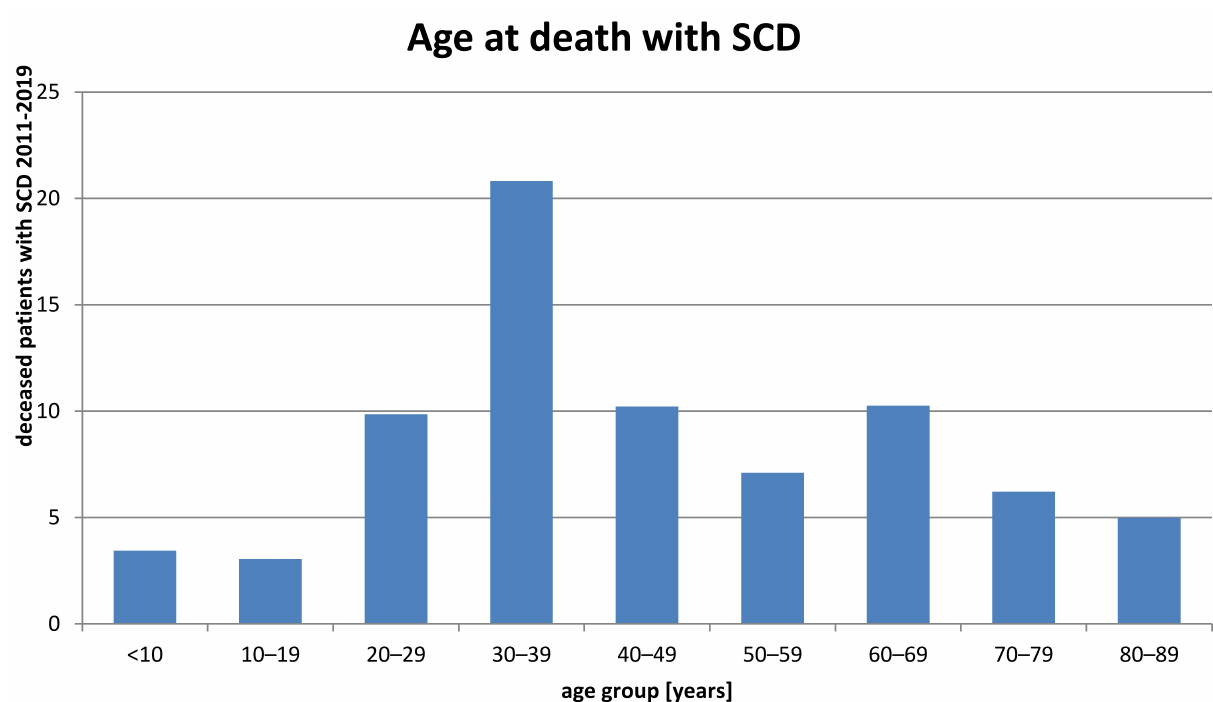
Figure 5. Age at death in patients with SCD. Age distribution of patients with SCD who died in the period